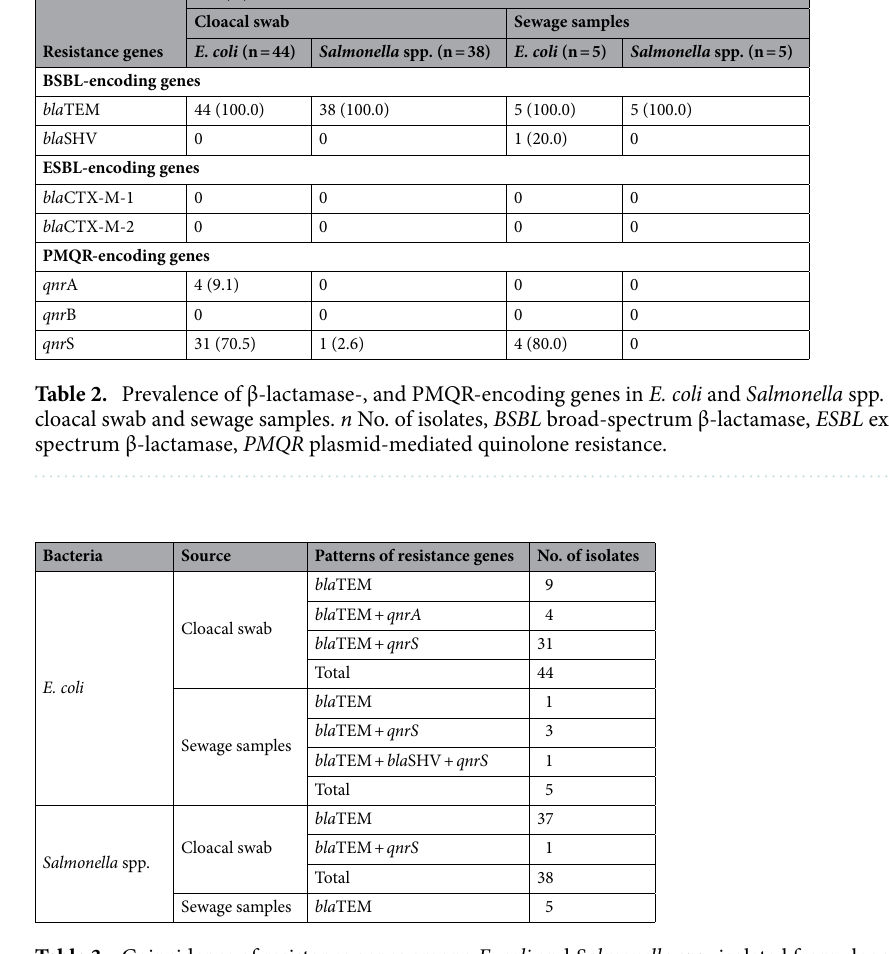
Table 3. Coincidence of resistance genes among E. coli and Salmonella spp. isolated from cloacal swab and sewage samples.